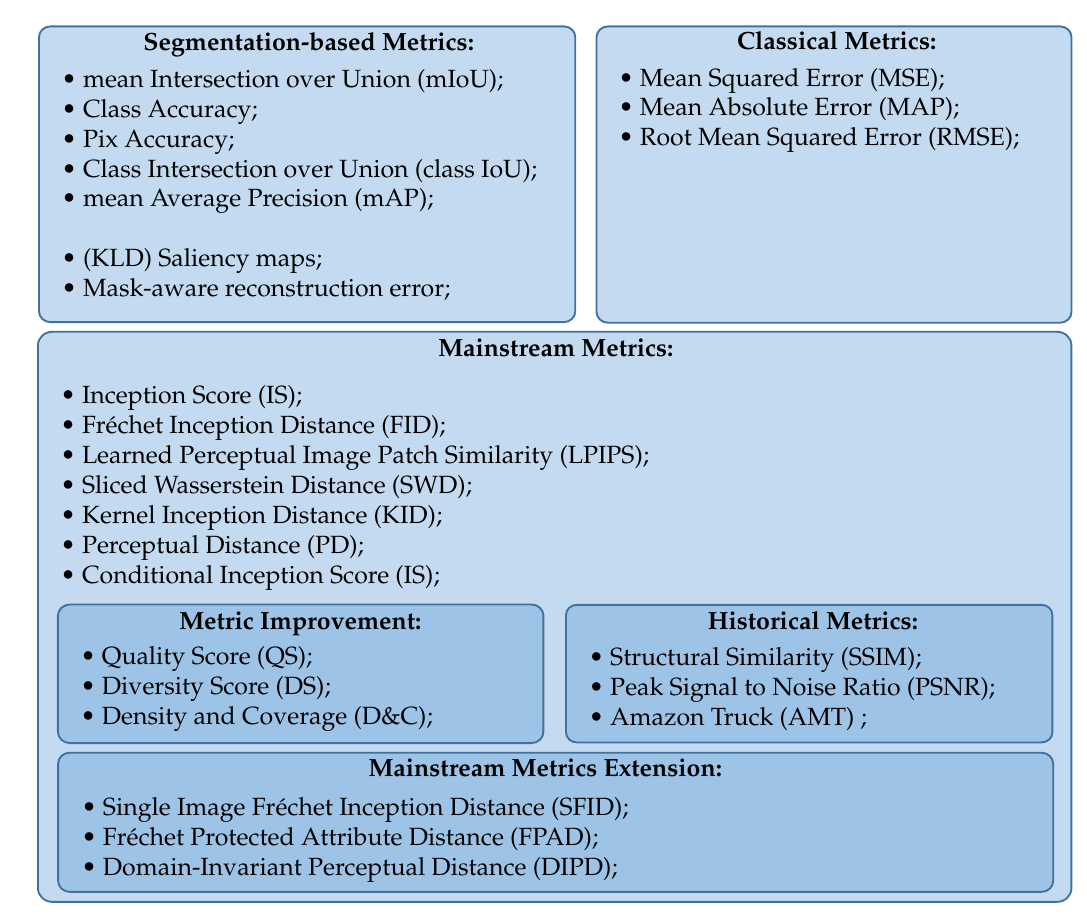
Figure 3. Categorization of metrics their main